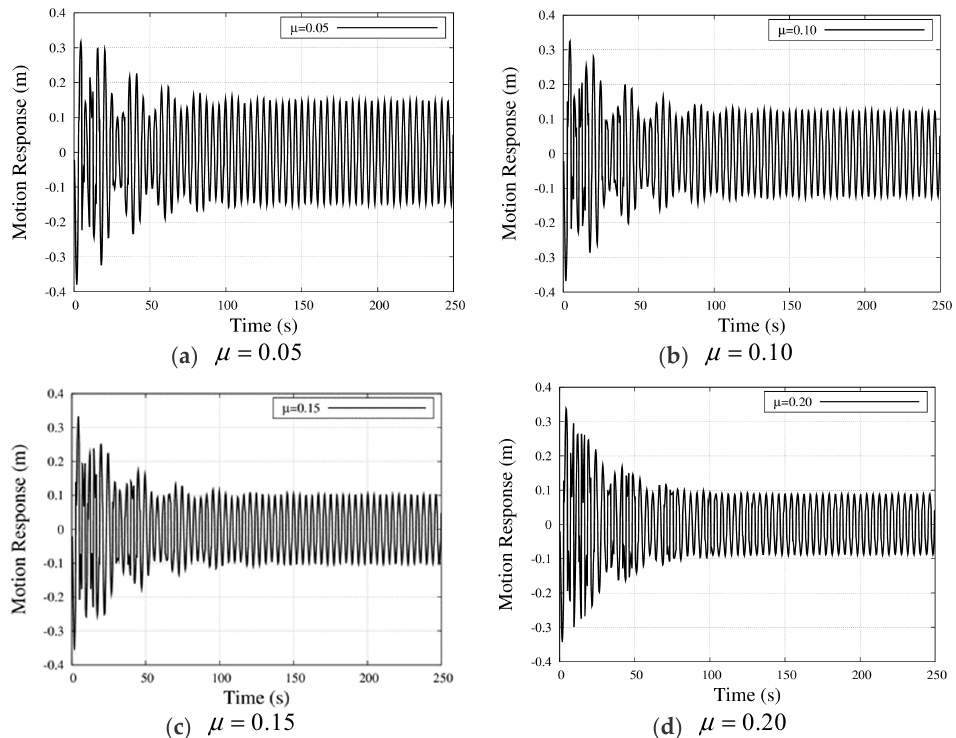
Figure 13. The motion response of the MJWEC with different dissipation coefficients.